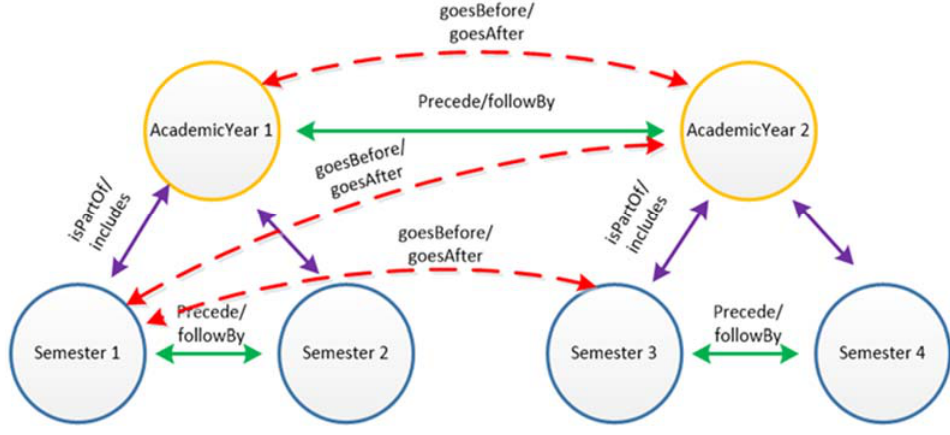
Figure 3. Relations between concepts—time periods.